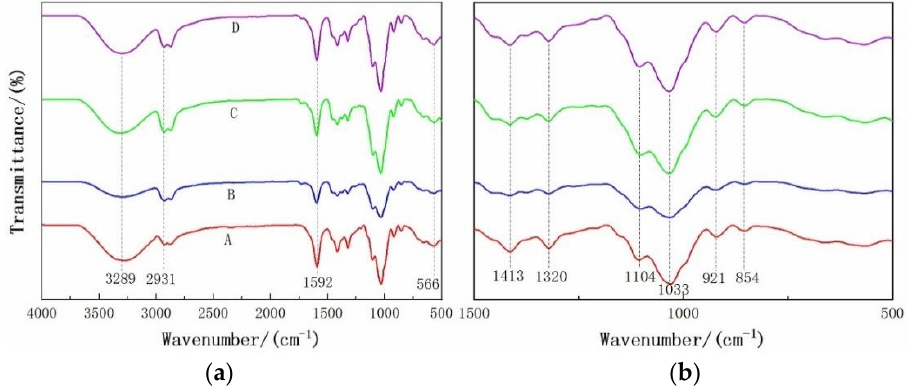
Figure 3. Results of FTIR analysis showing ATR infrared spectroscopy measurement ( a ) and an enlarged view of the same section ( b ) with wavenumbers of 1500 – 500 cm −1 . A: Control film (CMC); B: CMC + 1% CFEO film; C: CMC + 2% CFEO film; D: CMC + 3% CFEO film. B: CMC + 1% CFEO film; C: CMC + 2% CFEO film; D: CMC + 3% CFEO